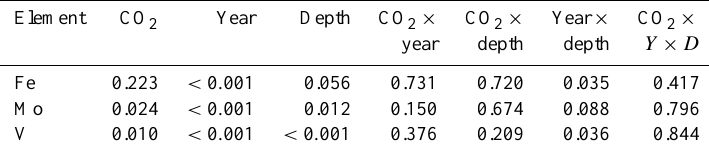
Table 4. Effect of elevated CO 2 , time, and soil depth on extractable nutrient concentrations for the last three years of the experiment (2005, 2006, and 2007). Values are P values from repeated measures, split-plot ANOVAs testing for the main effect of CO 2 treatment, repeated measures effect of the year, and split-plot effect of the depth, as well as all interactions. All data were log-transformed before analysis.